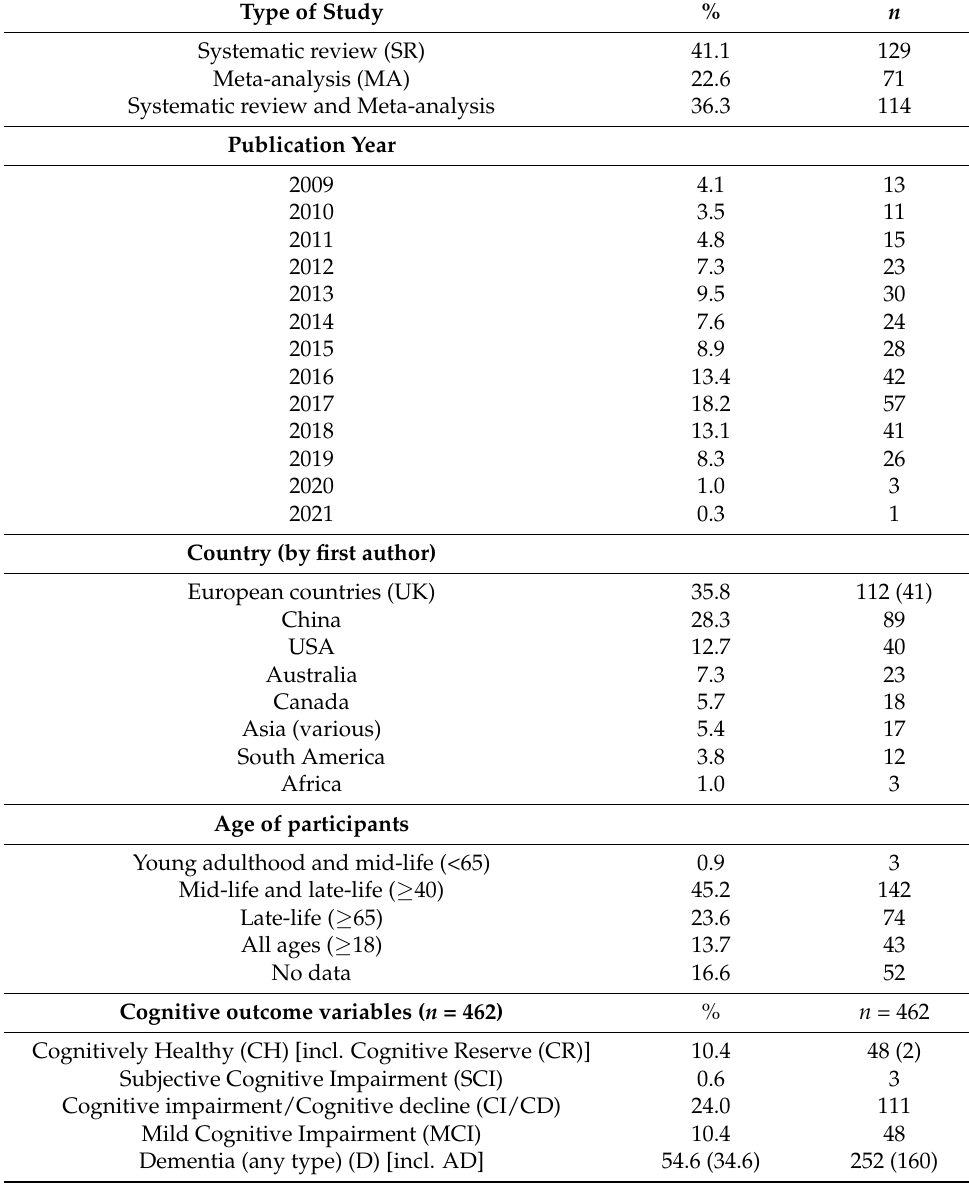
Table 1. Characteristics of the studies included in the review ( n =